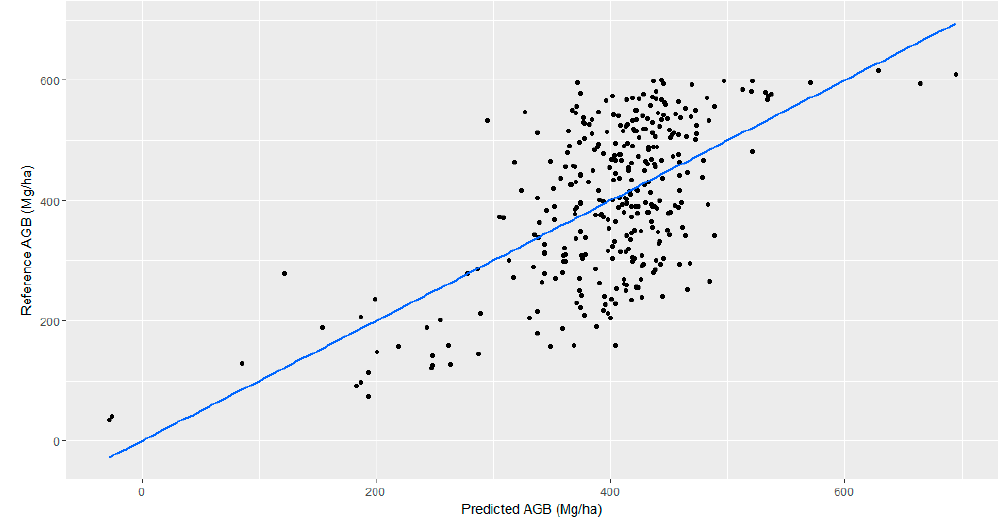
Figure 15. Relationship between predicted and reference AGB.